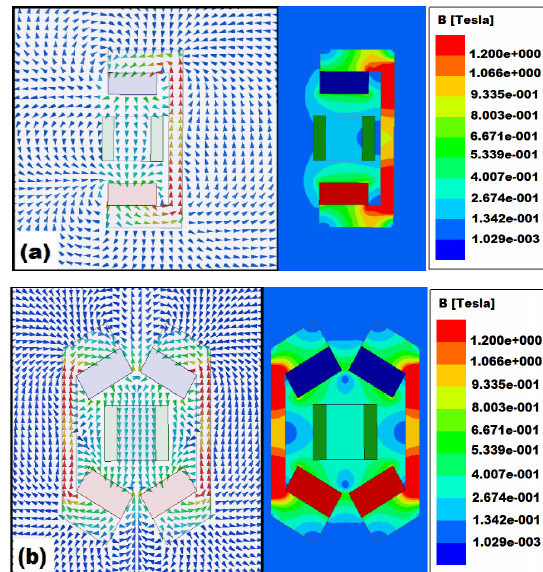
Figure 9: Magnetic flux density for: (a) augmented railgun with 2 magnets. (b) Augmented railgun with 4 magnets.